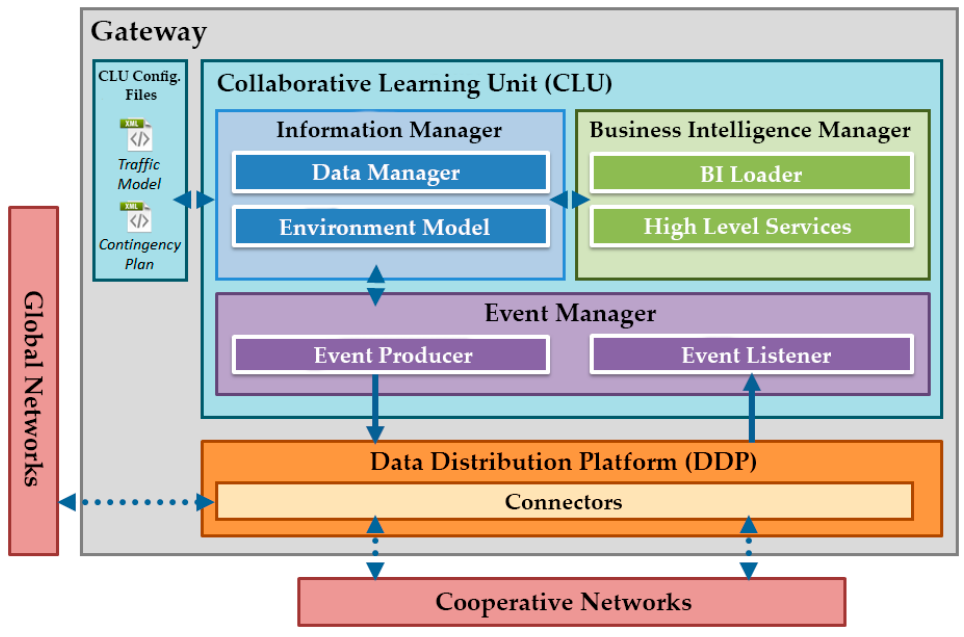
Figure 3. Architecture and technical design of the CLU.